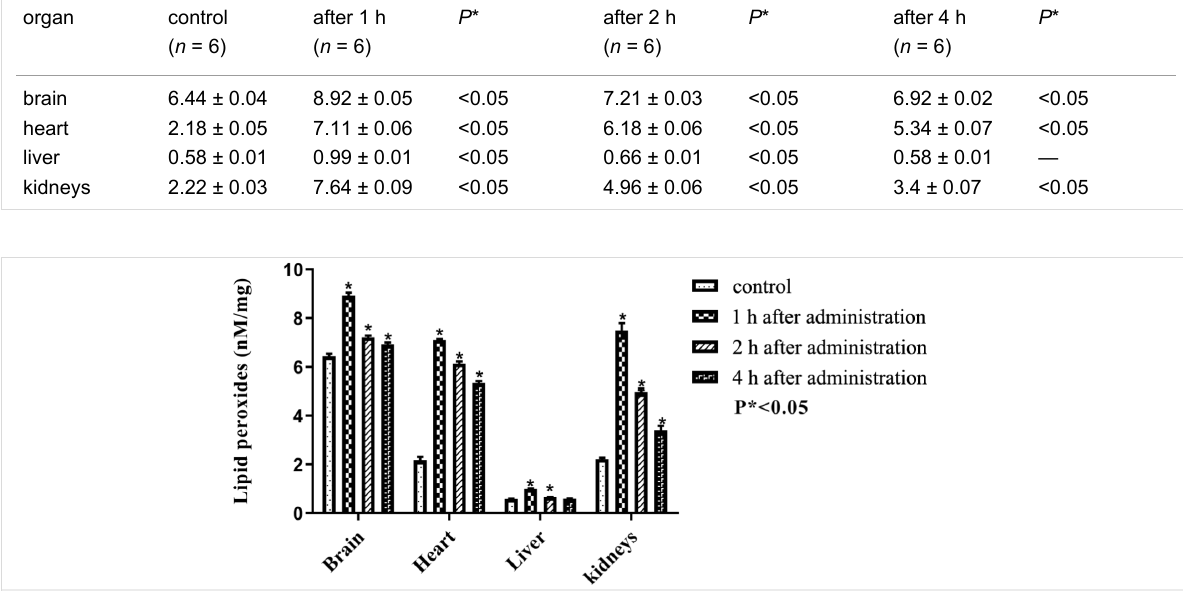
Figure 6: Levels of lipid peroxides after intraperitoneal administration of PEG-nGO; error bars: one standard deviation.